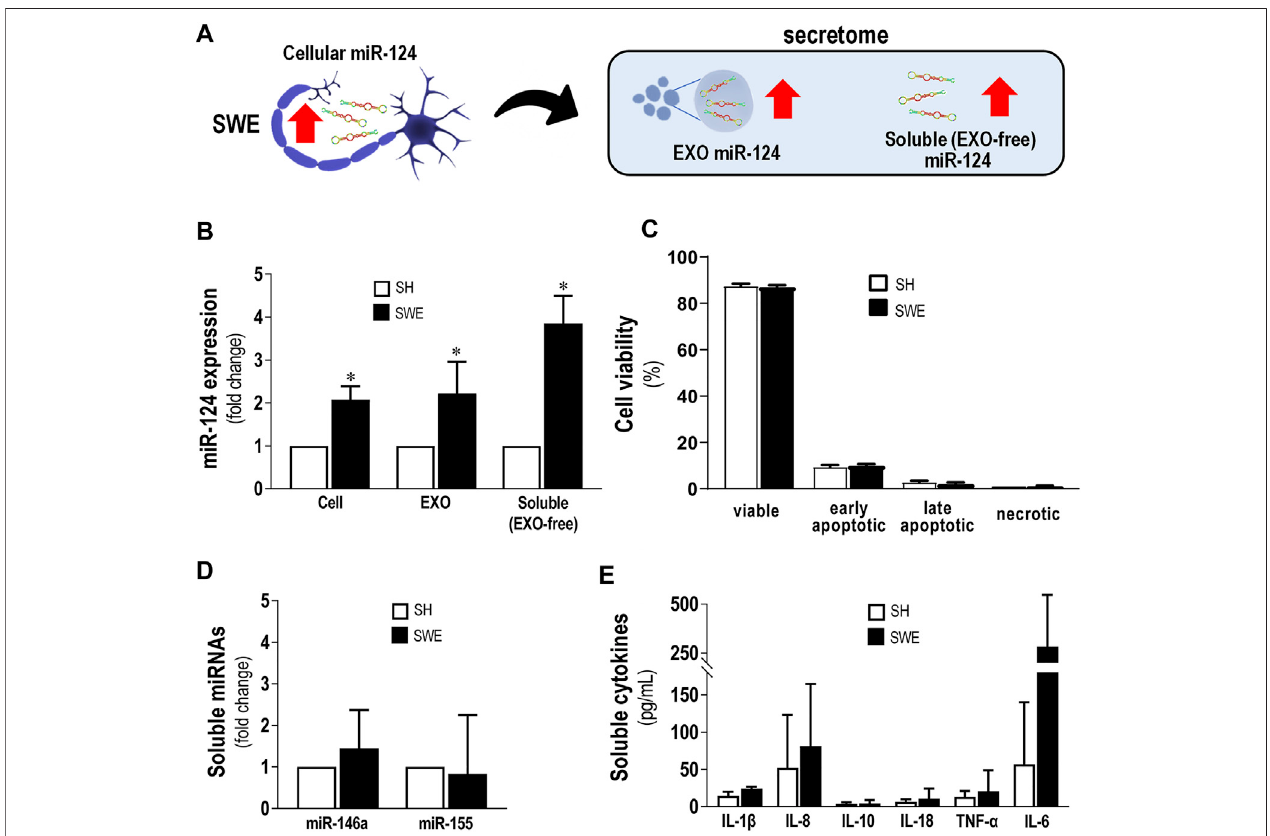
FIGURE 1 | Upregulated levels of miR-124 in SWE cells do not modify cell viability or secretion of in fl ammatory miRNAs and cytokines. Cells were differentiated using 10 µM retinoic acid for 7 days before experiments, as described in the Materials and Methods section. (A) Schematic representation of miR-124 increase in SWE cellsandtheirsecretome,includingbothexosomal(EXOs)andexosome-free(EXO-free,soluble)fractions. (B) CellularmiR-124expressioninSHandSWEcellsandtheir respective EXOs and EXO-free secretome. (C) SH and SWE cell viability by the Nexin fl ow cytometry assay. Four cell populations were distinguished: viable (V-PE and 7-AAD double-negative), early apoptotic (V-PE positive and 7-AAD negative), late apoptotic (V-PE and 7-AAD double-positive), and necrotic cells/cellular debris (V-PEnegativeand7-AADpositive). (D) LevelsofmiR-146aandmiR-155insecretomesfromSHandSWEcells. (E) Pro fi leofin fl ammatory-associatedcytokinelevelsin theEXO-freesecretomesfromSHandSWEcellsusingtheLEGENDplex fl owcytometryassay.Resultsaremean±SDfromatleastthreeindependentexperiments.* p < 0.05 vs . SH levels, two-tailed Student ’ s t -test. miR, miRNA; SH, human SH-SY5Y wild-type neurons; SWE, human SH-SY5Y expressing the APP695 Swedish mutant protein; EXO, Exosomes; IL, interleukin; TNF- α , tumor necrosis factor α